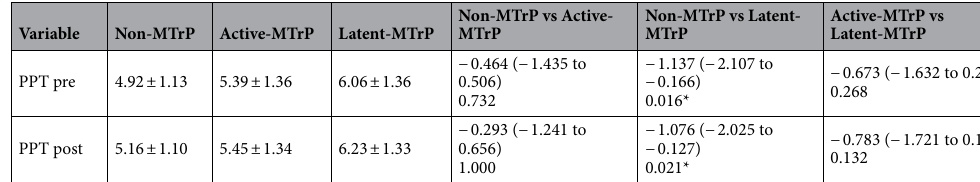
Table 4. PPT over tibialis muscle. Comparison between groups. Comparison between groups: Difference of means, Confidence interval and P value according to Bonferroni’s correction. *Indicates statistical significance P <